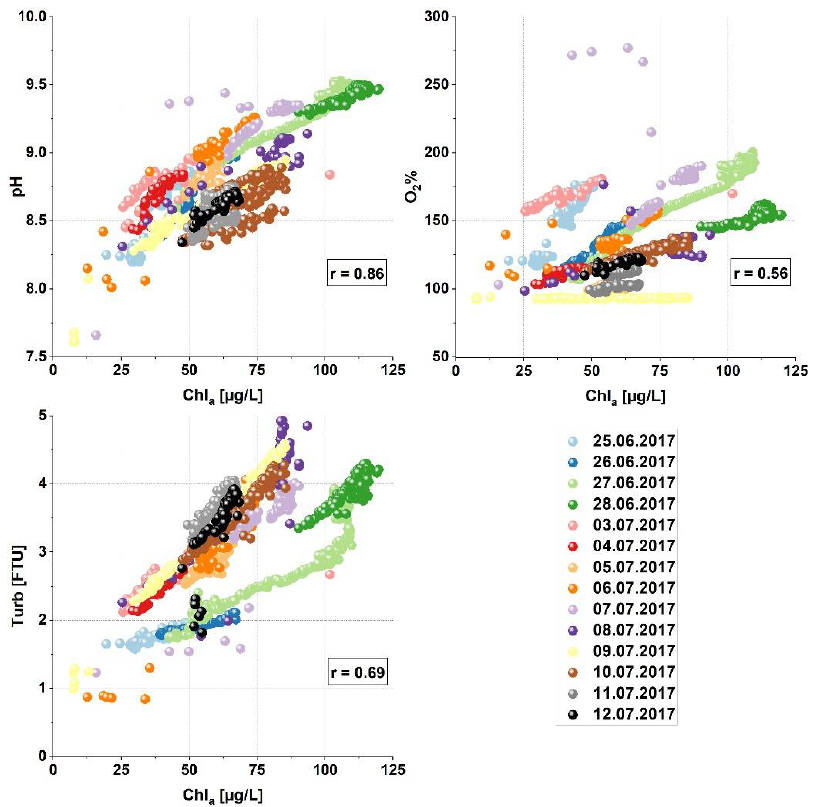
Figure 6. Scatter plots representing the correlation between Chlorophyll a (Chl a ) and pH (r = 0.86), O 2 % (r = 0.56) and Turbidity (Turb) (r = 0.69). Observation points are colored according to the sam- pling date. Varying linear relationships between Chl a and the other BIOFISH parameters can be observed for the different sampling